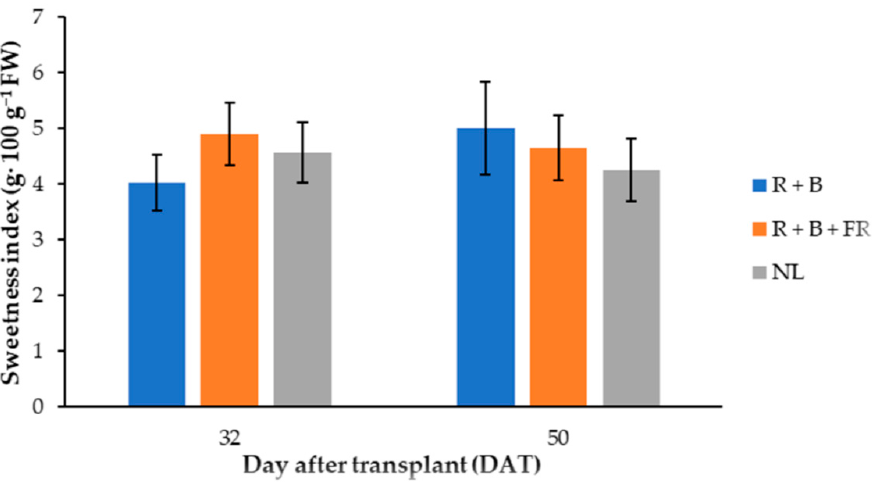
Figure 5. Sweetness index of “Carosello leccese” ( Cucumis melo L.) fruits grown under solar light (NL, no supplementary lighting) and two light spectra (see Figure 1) 32 and 50 DAT. Values are an average of three replications. Vertical bars represent mean values ± standard error. R + B represents supplementary light with red + blue spectra; R + B + FR represents supplementary light with red + blue + far red spectra; NL represents solar light (control) treatment.